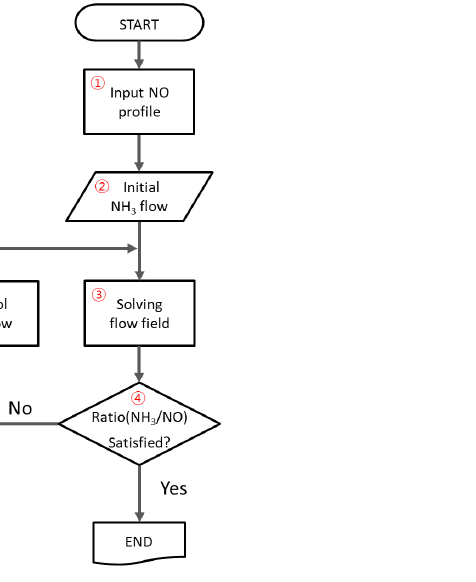
Figure 5. Computing procedure for AIG nozzle flow optimization.